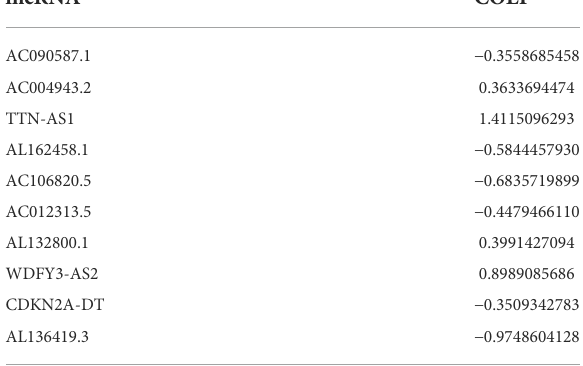
TABLE 2 The correlation coef fi cient of